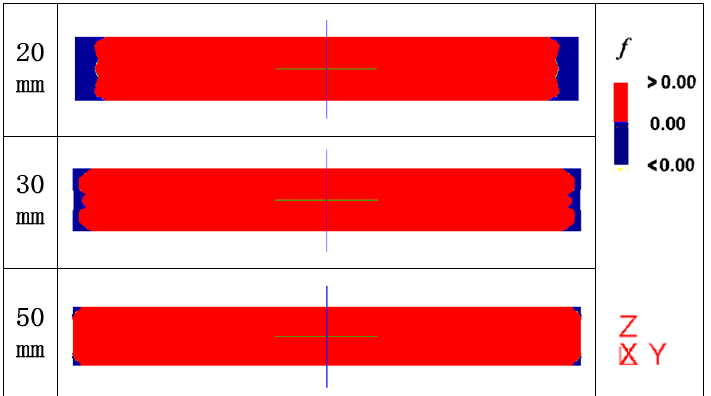
Figure 10. Regions where dynamic recrystallization (DRX) was triggered on the cross section of the slab during HHR 2 .